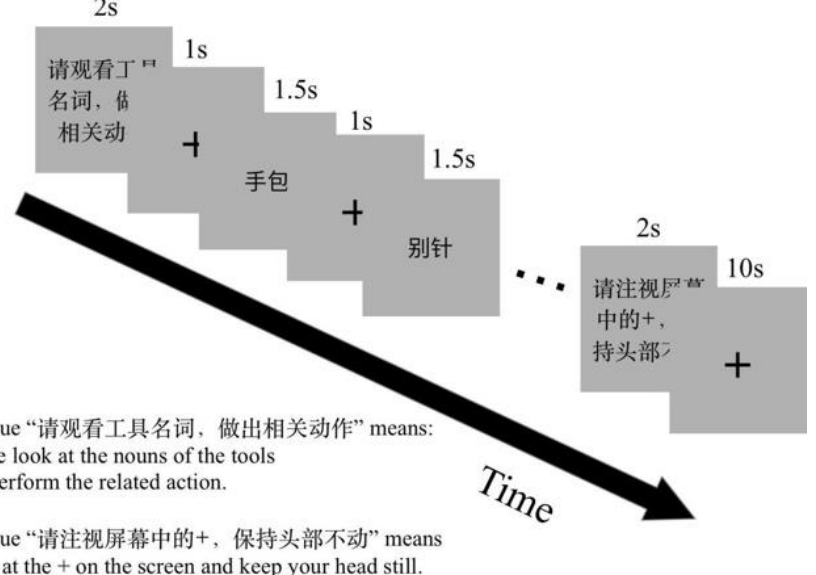
Figure 2. The fMRI experiment paradigm design. There were two scan runs in this experiment. One run comprises three tasks: NR, to silently read an object noun; NA, to perform a hand gesture to an object noun; NV, to silently generate a verb to an object noun. Before the task block, a visual cue was presented to prompt the task.